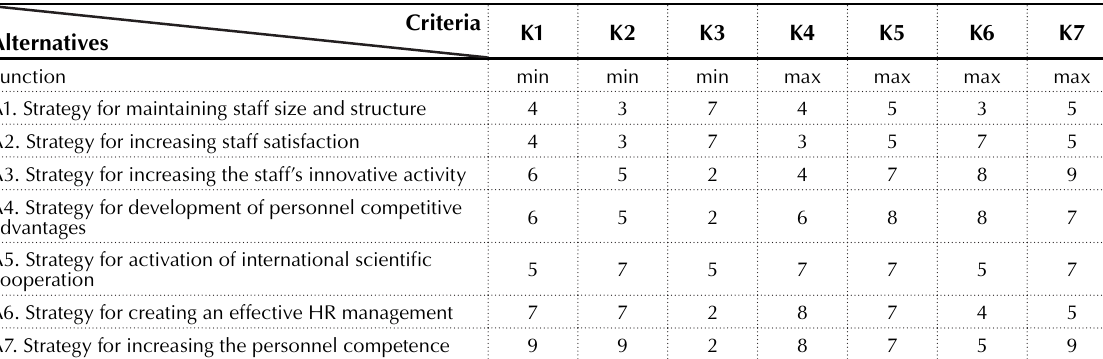
Table 2. Output data (decision matrix) on ranking strategies for human capital development using the SAW